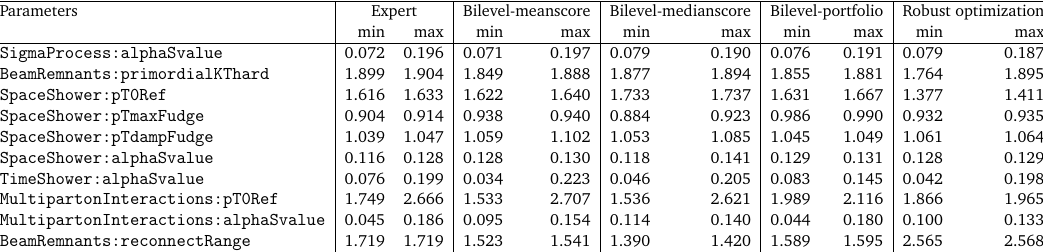
Table 33: Eigentune results for the A14 dataset using the optimal physics parameters p ∗ obtained with the different optimization methods when using the cubic polynomial